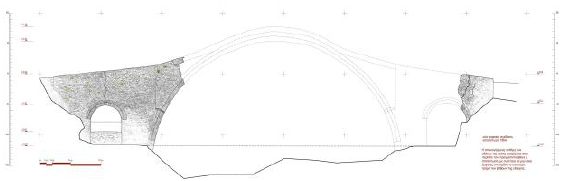
Figure 5. 3D textured meshes clouds of the (a) west and (b) east ruins.